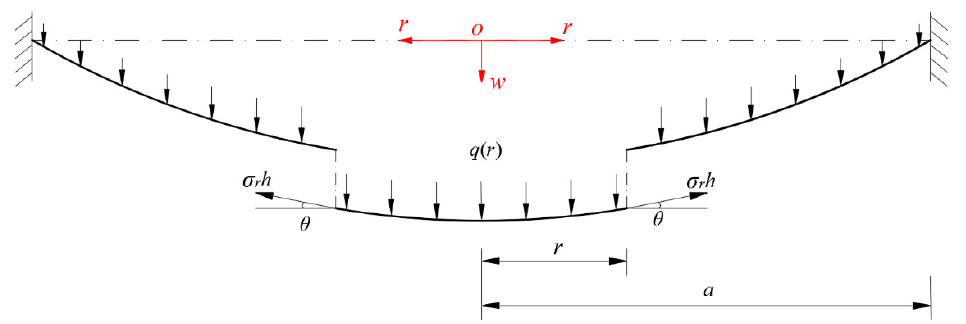
Figure 2. Sketch of a free body with radius 0 ≤ r ≤ a . Adapted from Refs. [18,29]. The free body shown in Figure 2 is subjected to the joint actions of the external action force F ( r ) produced by the transverse loads q ( r ) within radius r and the total force 2 π r σ r h produced by the membrane force σ r h acting on the boundary r . Obviously, the external force F ( r ) produced by q ( r ) within r is equal to the weight of the liquid within r , and is given by